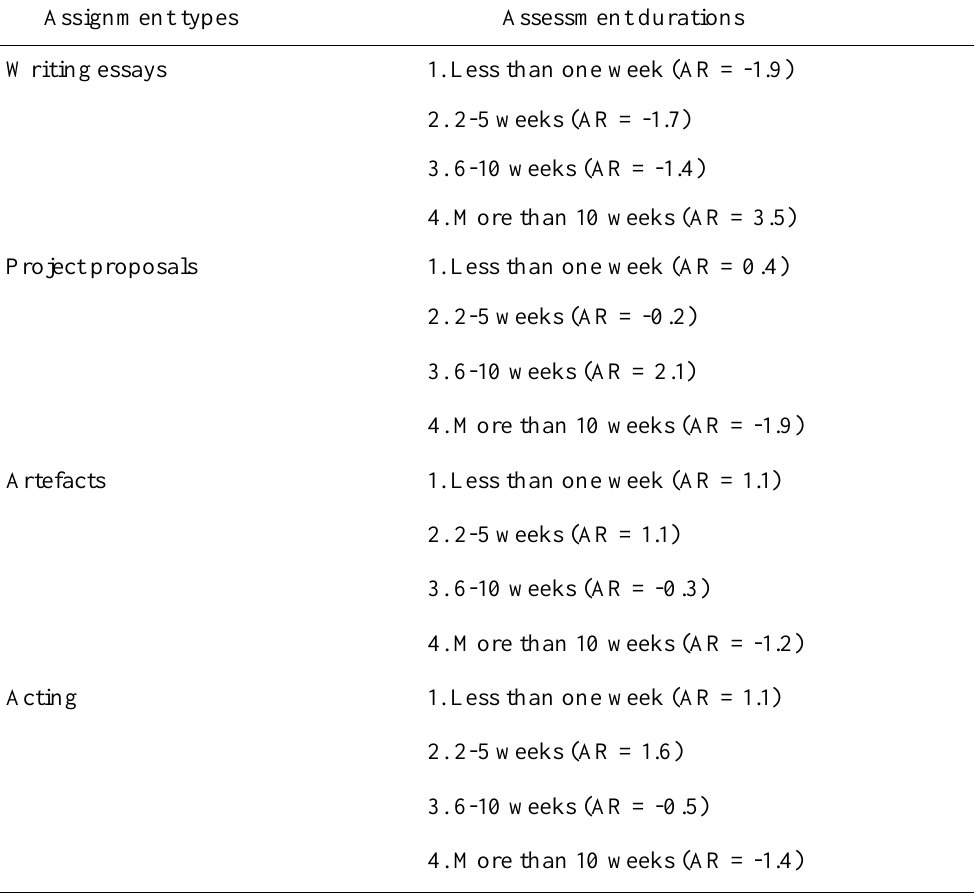
Relationships Between Assignment Types and Assessment Durations Assignment